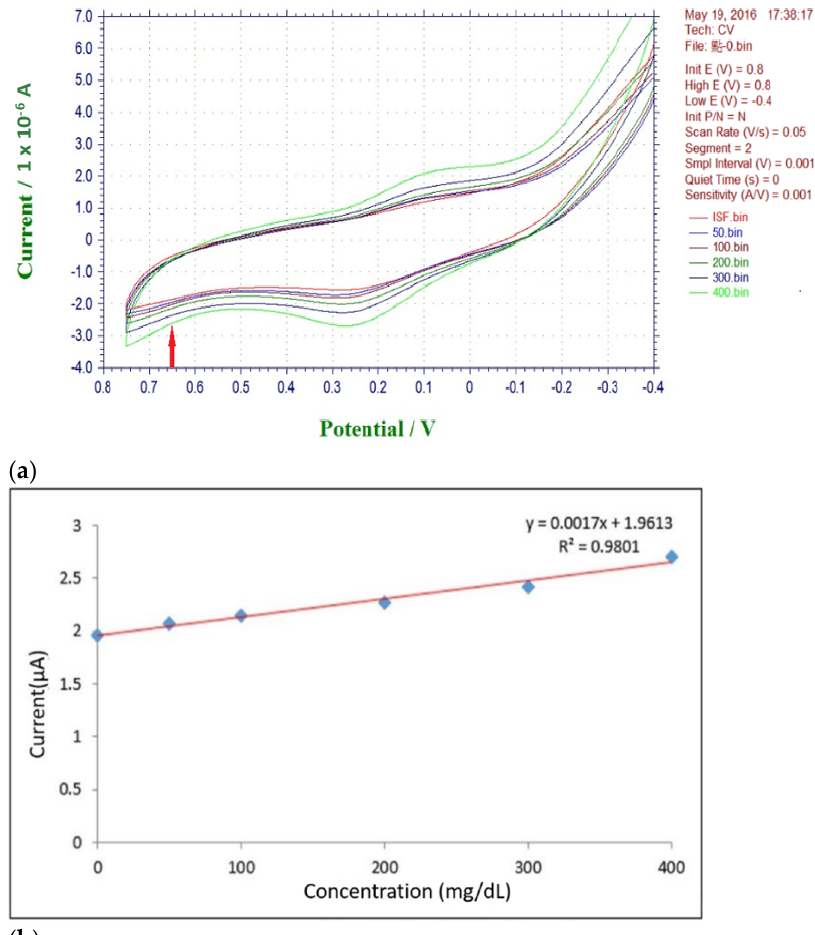
Figure 8. ( a ) Maximum change at 0.65 V for different concentrations of blood glucose; ( b ) current vs. ISF + Glucose concentration at a potential of 0.65 V. Results showed linearity at an operation voltage of 0.65